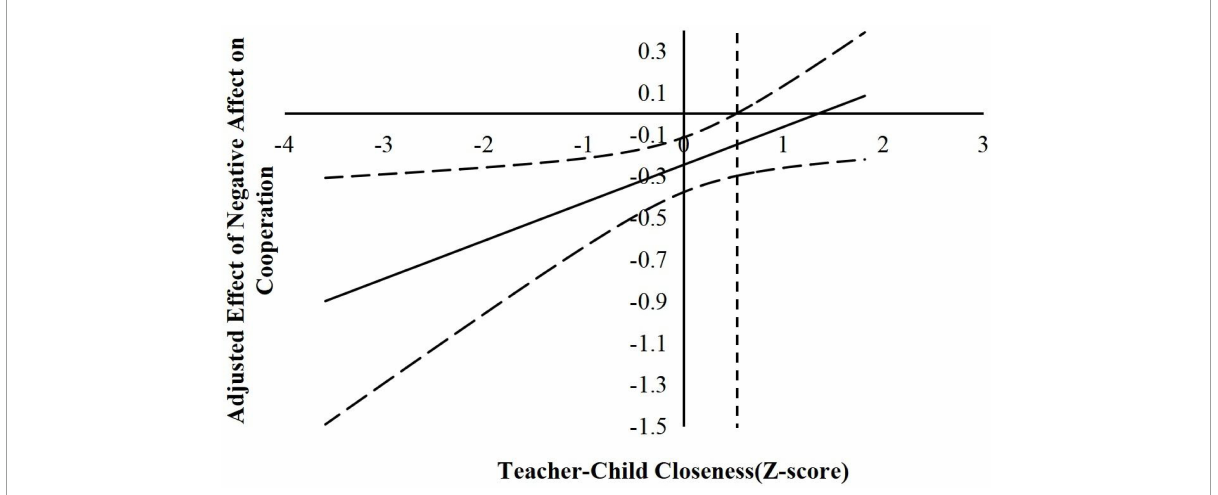
FIGURE2 The moderating effect of teacher-child closeness in the prediction of children’s negative affect on cooperation. The dashed vertical line indicates the point along the teacher-child closeness in which the negative affect regression coefficient transitions from significance (left of the dashed vertical line) to non-statistical significance (right of the dashed vertical line). The value of the dashed vertical line was 0.53.